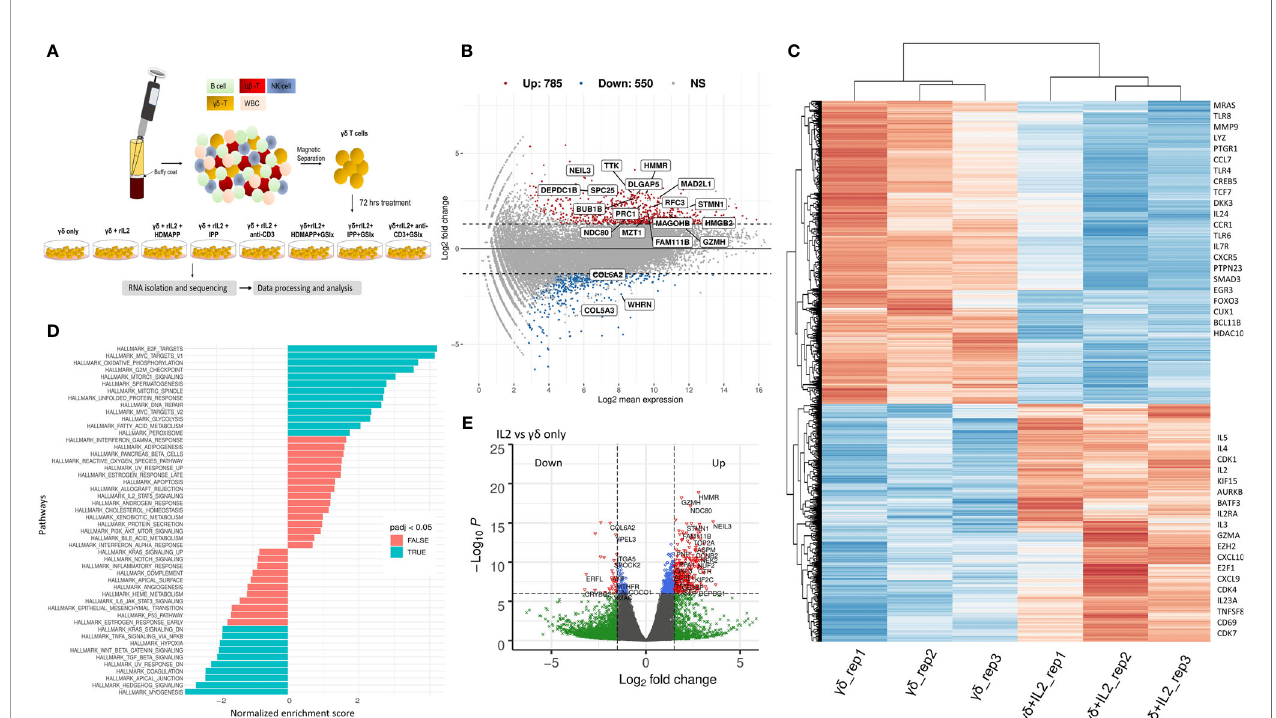
FIGURE 1 | IL2 mediated signaling reshapes gd T cell gene expression. (A) Schematic of gd isolation, treatment regime, and RNA-seq. (B) Overall gene dysregulation upon IL2 treatment was plotted using MA function for fold change vs. normalized expression (n = 3). Boxed genes shown are dysregulated by 2.5- logFC with an FDR of 0.05. (C) Clustered heatmap for topmost differentially regulated genes upon IL2 treatment (n = 3 for each treatment). Key differentially regulated cytokine and effector genes are labeled. (D) Functional GeneSet Enrichment Analysis (fGSEA) was performed for Gene Ontology (GO) term or Hallmark enrichment terms. (E) Volcano plot for fold change vs. p-value. Intersecting lines indicate the logFC cutoff. Colors as indicated; gray, NS; blue, logP = − 6; green, FC = 1.5; red, FC = 1.5 and logP = −